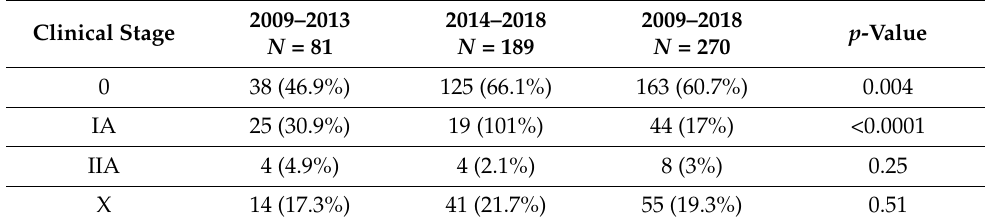
Table 1. Patients divided by